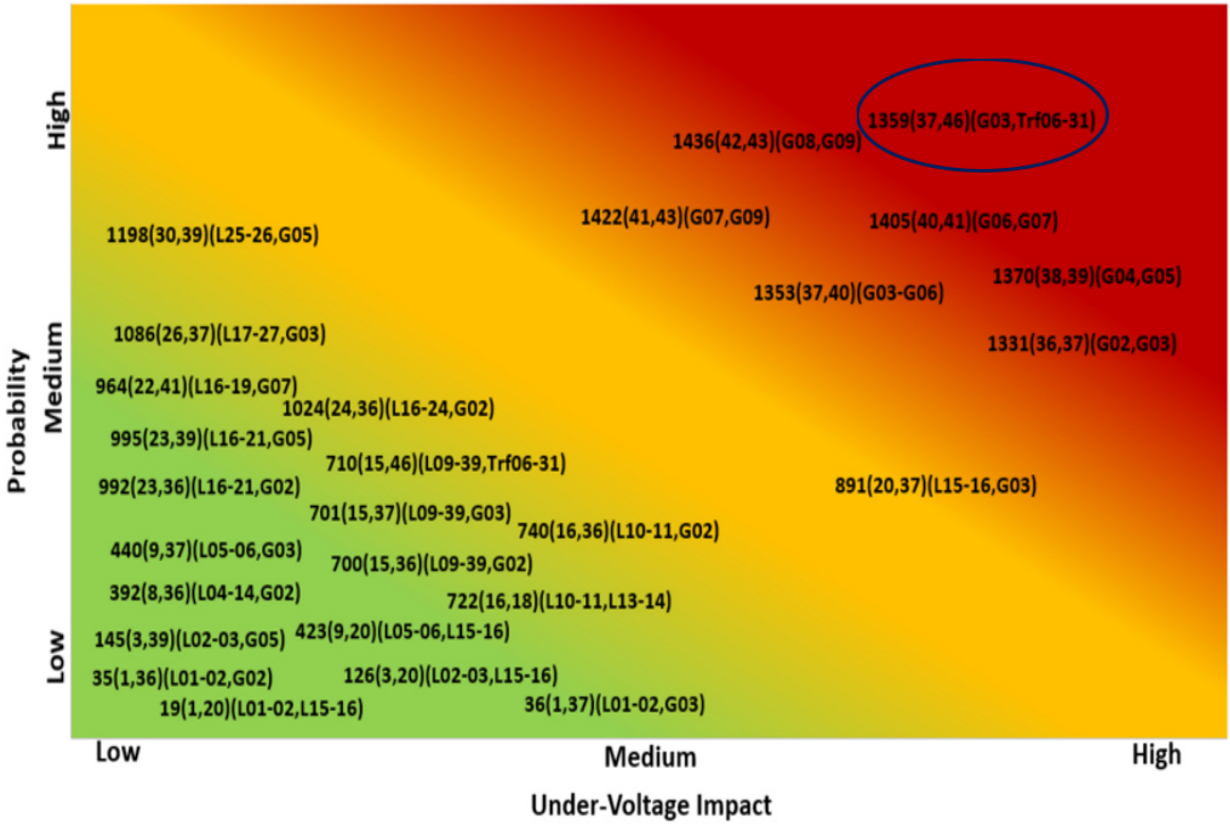
Figure 8. Risk-based undervoltage contingencies chart. For example, contingency number 1359 (indicated) in which component number 37 (G-03) and component number 46 (Trf 06–31) fall in the high impact high probability (HIHP) region.